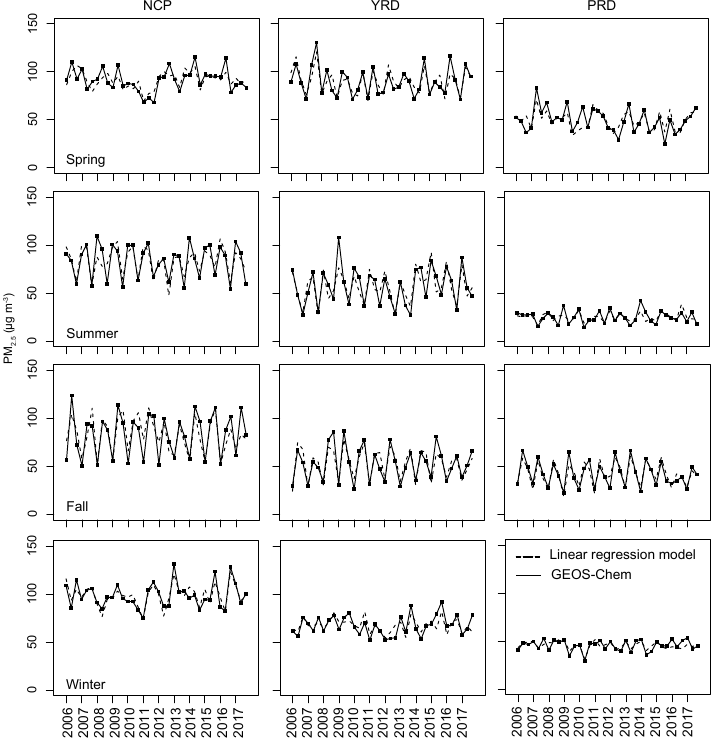
Figure 2. GEOS-Chem-simulated (solid line) and multiple linear regression-predicted (dashed line) monthly mean PM 2.5 in NCP, YRD, and PRD.